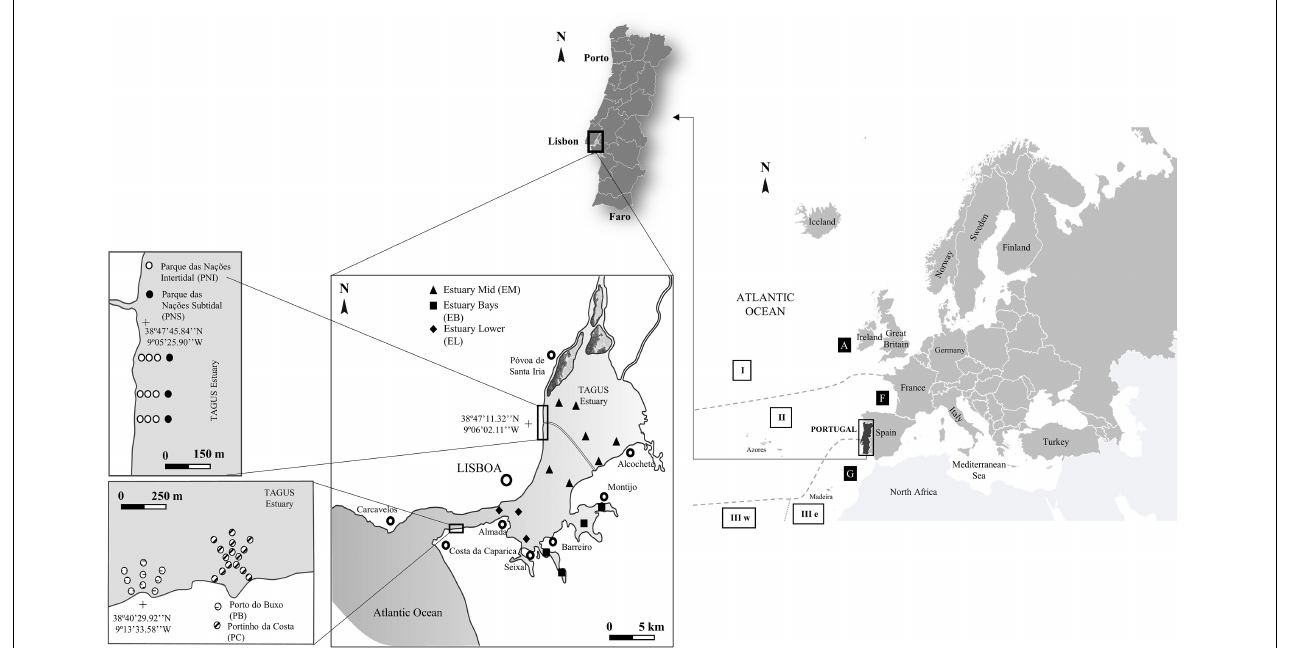
FIGURE 1 | Location of the sampling stations in the Tagus estuary: Porto do Buxo (PB); Portinho da Costa (PC); Parque das Nações Intertidal (PNI); Parque das Nações Subtidal (PNS); Estuary Middle (EM); Estuary Bays (EB) and Estuary Lower (EL). Ocean realms: I (variable westwarard current); II (weak and variable